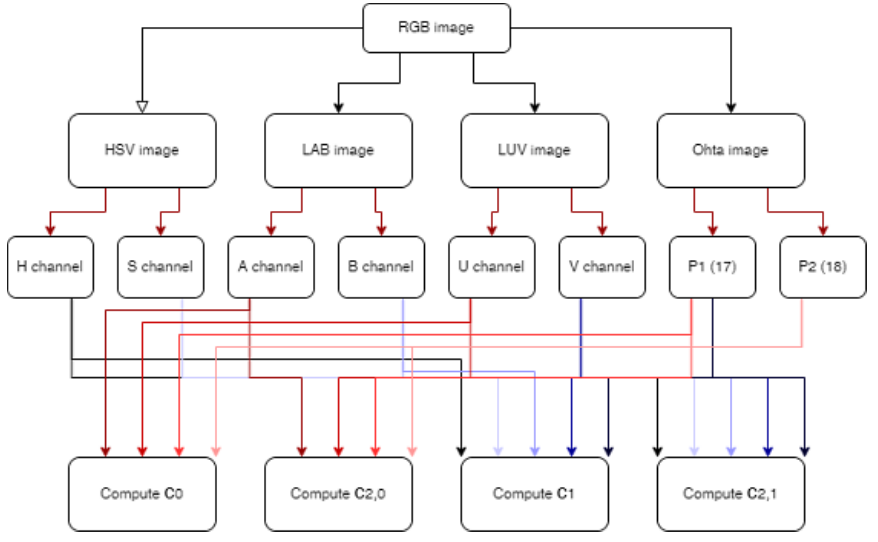
Figure 2. Flowchart of probability map construction.